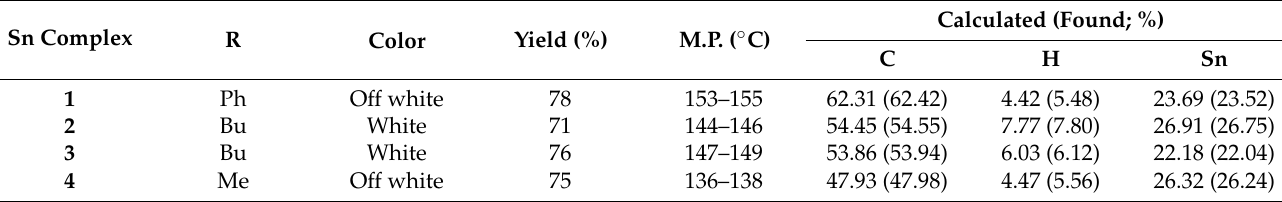
Table 1. Physical properties and analysis of complexes 1 – 4